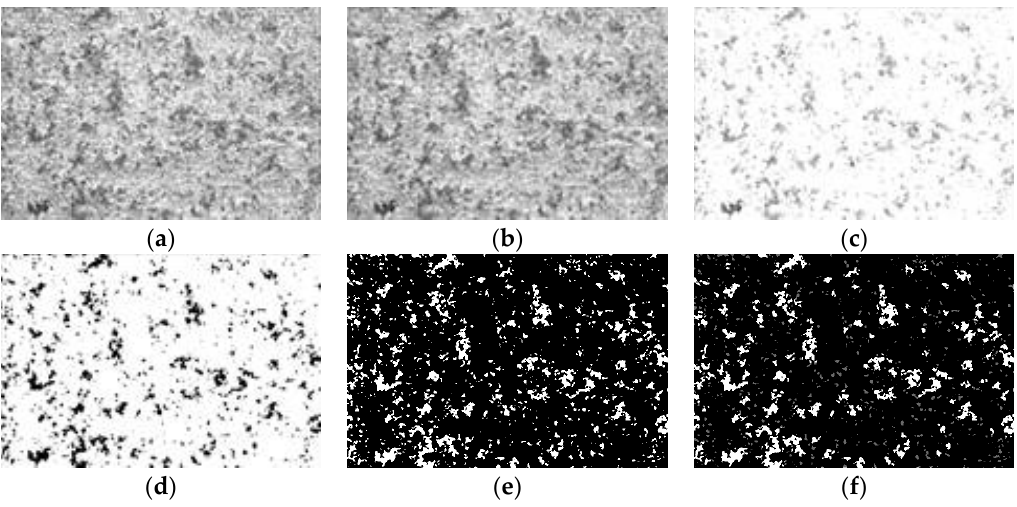
Figure 8. Image processing results of DWD feature computation. ( a ) The image before median filtering; ( b ) the image after median filtering; ( c ) the image after enhancement; ( d ) the image after threshold segmentation; ( e ) the image after a non-logical operation; ( f ) the image after the analysis of aggregation degree.